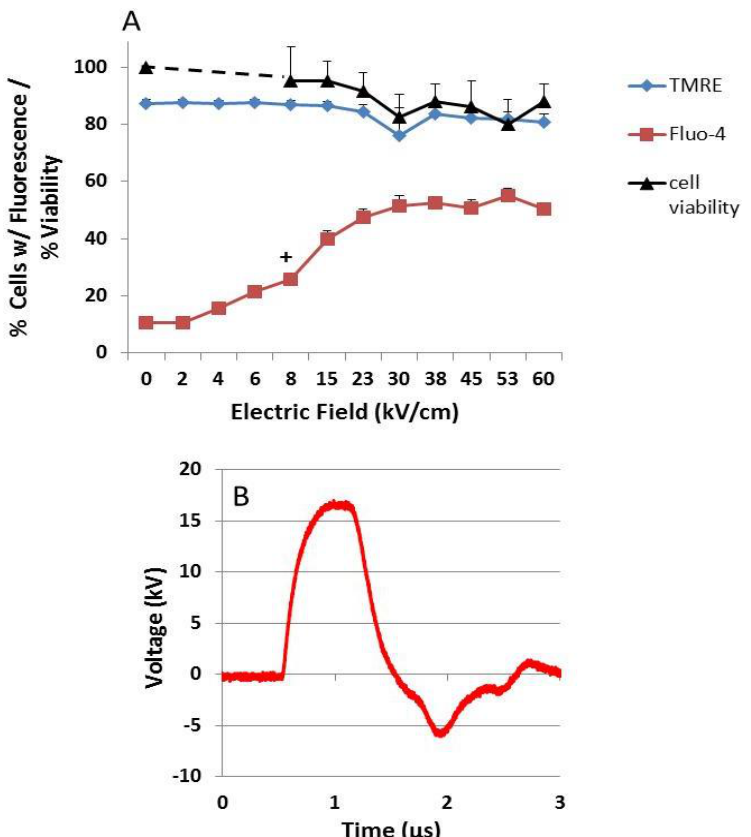
Figure 3. Ns (cid:51)(cid:40)(cid:41)(cid:3)(cid:72)(cid:73)(cid:73)(cid:72)(cid:70)(cid:87)(cid:86)(cid:3)(cid:82)(cid:81)(cid:3)(cid:507)(cid:524)(cid:80)(cid:3)(cid:71)(cid:72)(cid:87)(cid:72)(cid:85)(cid:80)(cid:76)(cid:81)(cid:72)(cid:3)(cid:89)(cid:76)(cid:68)(cid:69)(cid:76)(cid:79)(cid:76)(cid:87)(cid:92)(cid:3)(cid:177) (A) N1-S1 HCC cells were loaded with Fluo-4 Direct to determine Ca 2+ influx (red squares) and with TMRE to determine (cid:507)(cid:524)(cid:80)(cid:3) (cid:11)(cid:69)(cid:79)(cid:88)(cid:72)(cid:3) (cid:71)(cid:76)(cid:68)(cid:80)(cid:82)(cid:81)(cid:71)(cid:86)(cid:12)(cid:3) (cid:68)(cid:86)(cid:3) (cid:71)(cid:72)(cid:86)(cid:70)(cid:85)(cid:76)(cid:69)(cid:72)(cid:71)(cid:3) (cid:76)(cid:81)(cid:3) the Experimental Section. The Y-axis indicates the percentage of cells with fluorescence for either Fluo-4 or TMRE, which were determined by flow cytometry 10 minutes after nsPEF treatment. In parallel experiments, the percentage of viable cells (black triangles) was determined 24 hours after treatment as described in the Experimental section. (B) Cells were treated with one 600 ns pulse with a 150 ns slow rise-fall time waveform (red line, panel B) with a mismatched load. Statistical differences vs. sham control (0 kV/cm): All n = 3; No significance with cell viability or with TMRE; for Fluo-4 (cid:15)(cid:3)(cid:68)(cid:79)(cid:79)(cid:3)(cid:72)(cid:79)(cid:72)(cid:70)(cid:87)(cid:85)(cid:76)(cid:70)(cid:3)(cid:73)(cid:76)(cid:72)(cid:79)(cid:71)(cid:86)(cid:3)(cid:149)(cid:3)(cid:27)(cid:3)(cid:78)(cid:57)(cid:18)(cid:70)(cid:80)(cid:15) *p < 0.03. (cid:36)(cid:49)(cid:50)(cid:57)(cid:36)(cid:3)(cid:55)(cid:88)(cid:78)(cid:72)(cid:92)(cid:182)(cid:86)(cid:3)(cid:70)(cid:82)(cid:85)(cid:85)(cid:72)(cid:70)(cid:87)(cid:76)(cid:82)(cid:81)